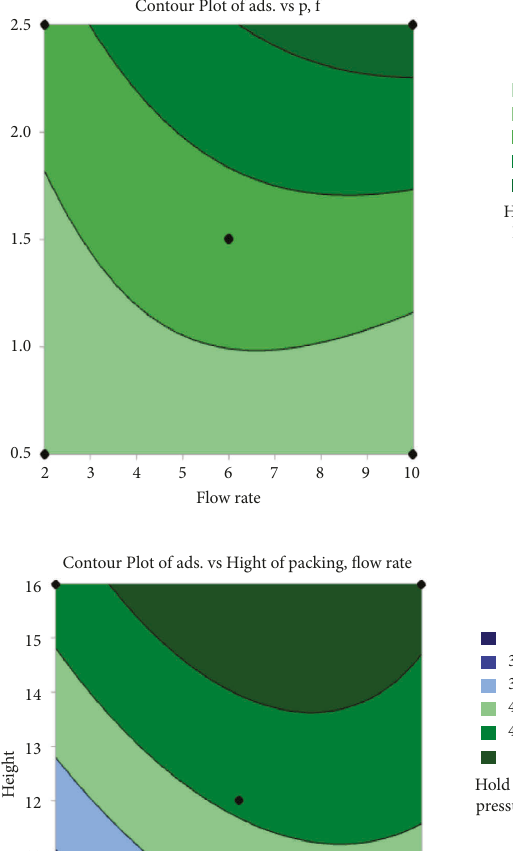
Contour Plot of ads. vs Hight of packing, flow rate